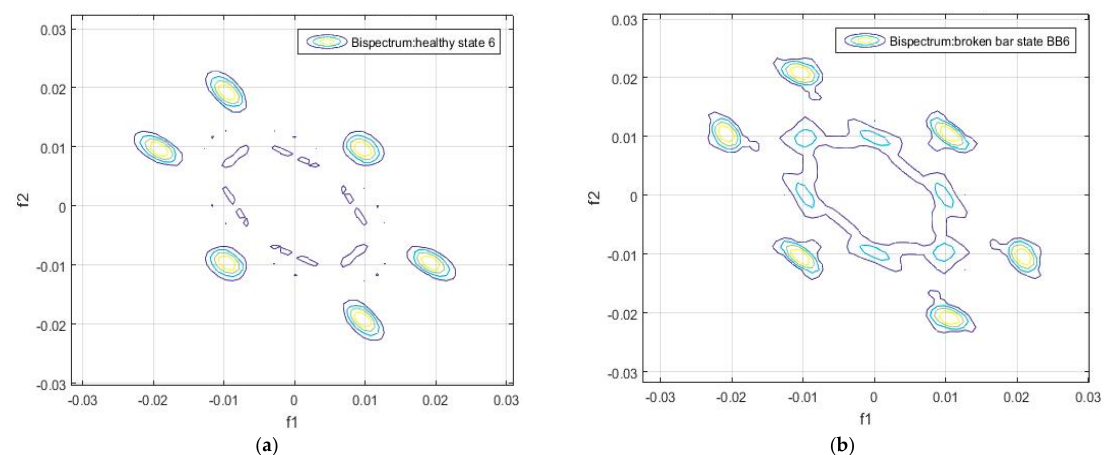
Figure 8. Contour of the bispectrum of the motor flux signal: ( a ) Sample 6 of healthy the motor, ( b ) Sample 6 of the damaged motor.